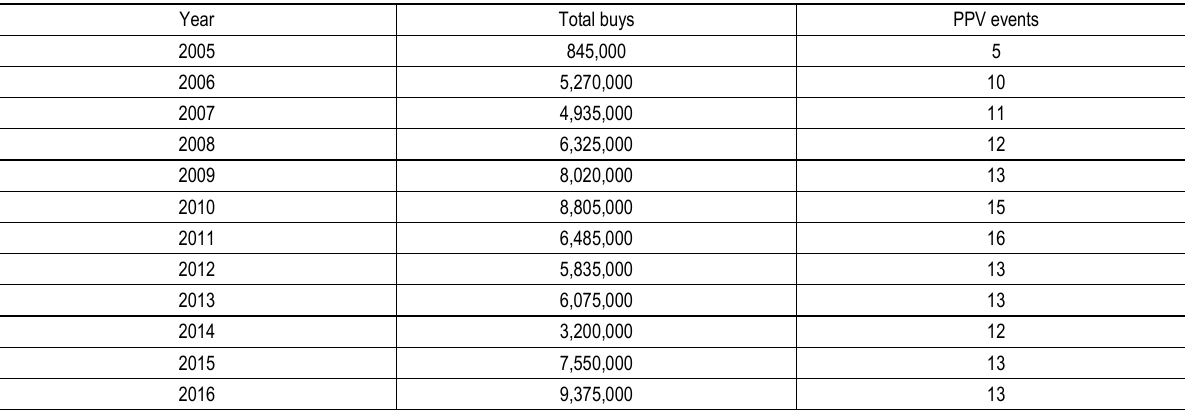
Fig. 3. PPV buys in the modern era Table 1. PPV buys by year in the modern